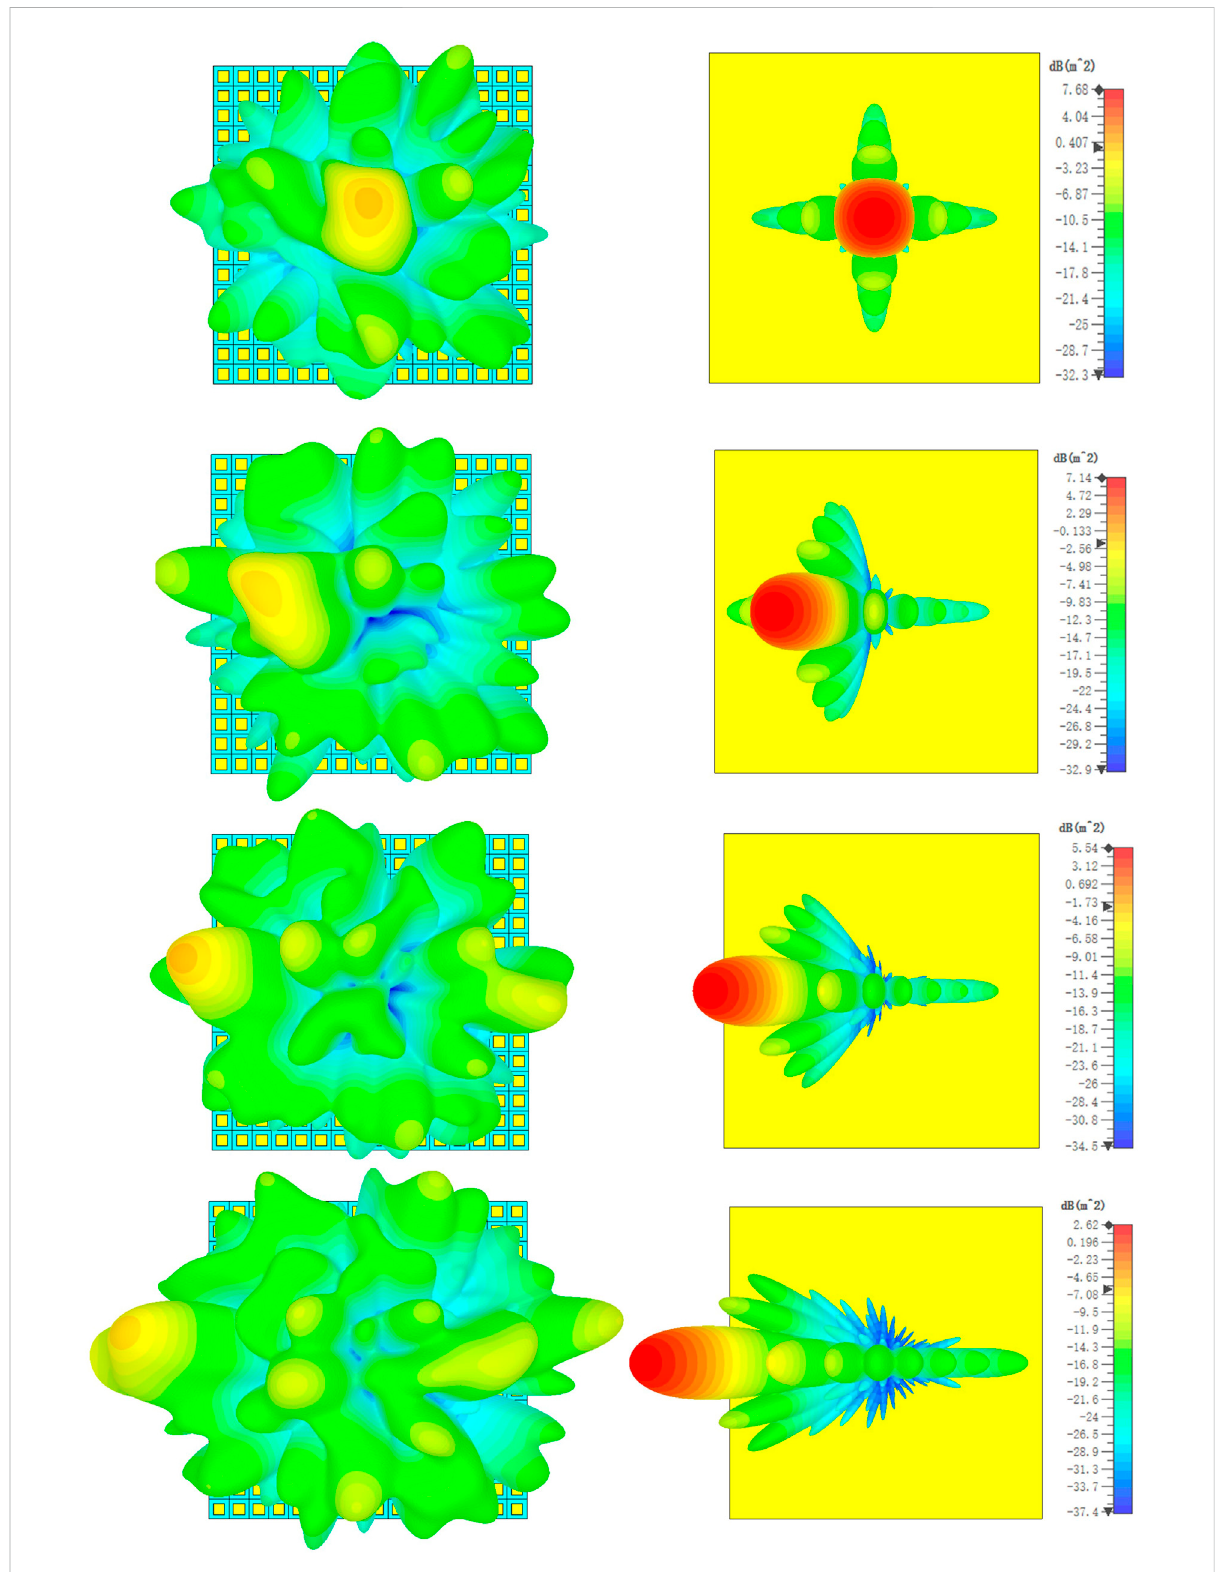
FIGURE 5 Simulated results concerning RCS of the metal plate and the metasurface at different θ in the upper z plane.